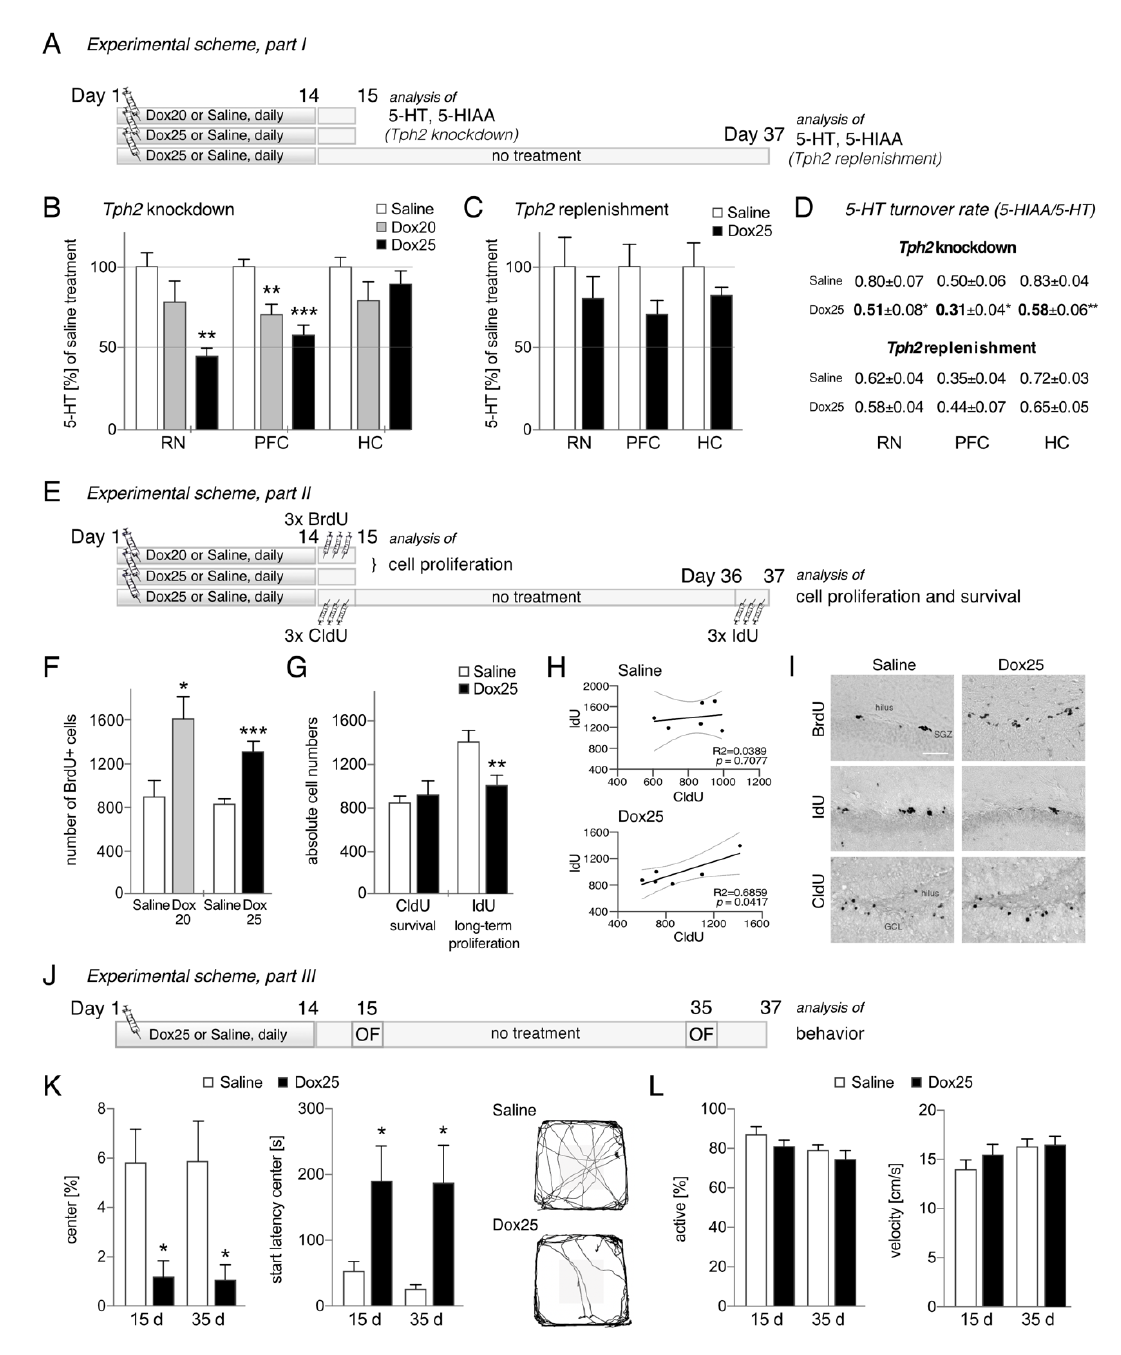
Figure 1. Effects of conditional brain serotonin knockdown, followed by recovery. ( A ) Experimental design part I: Tph2 knockdown and Tph2 replenishment to manipulate serotonin (5-HT) levels. TetO-shTPH2 transgenic rats received